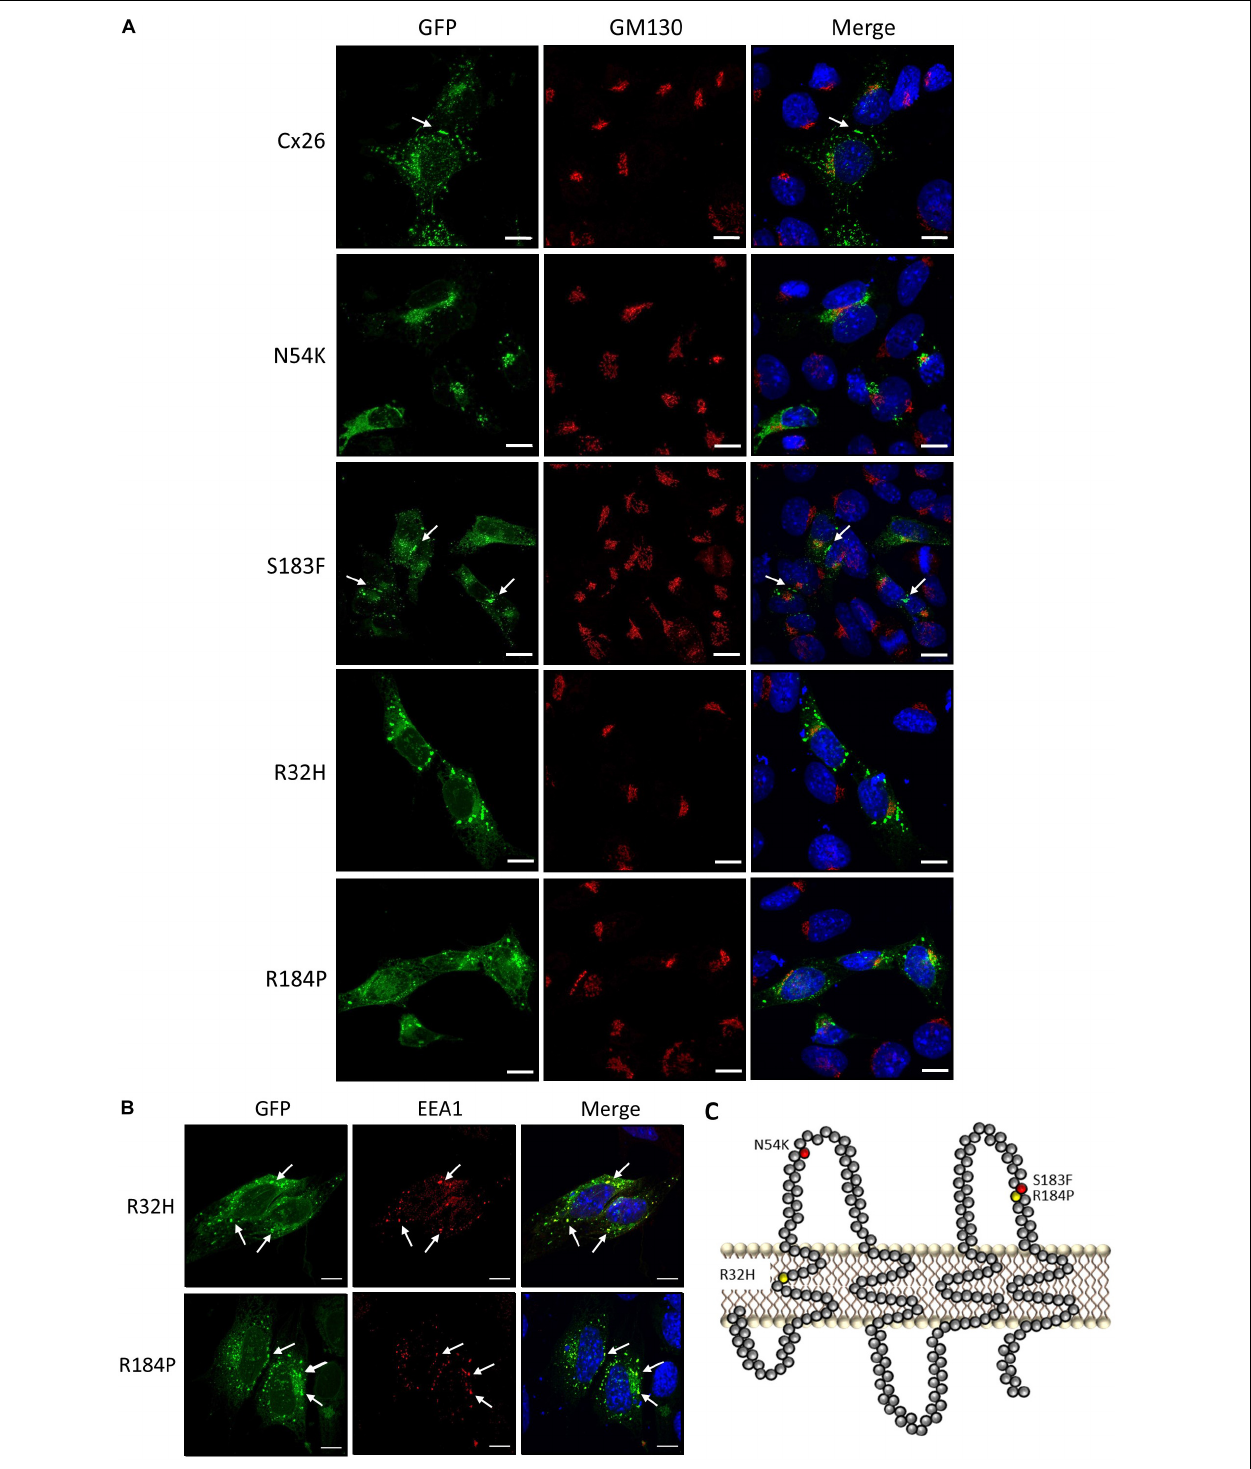
FIGURE 3 | Intracellular localization of syndromic and non-syndromic hearing loss-linked Cx26 mutants (A) Representative micrographs of Cx26-GFP and various GFP-tagged hearing loss-linked Cx26 mutants transiently expressed in Cx43 KO cells. Cells were co-immunolabeled with GM130 (red) to visualize the location of the Golgi apparatus and Hoechst (blue) to visualize the nuclei. The N54K, R32H, and R184P mutants failed to form gap junctions. Arrows denote gap junction plaques. (B) A sub-population of the R32H and R184P mutants co-localized with EEA1, an early endosomal marker, denoted by arrows. (C) Topological model of Cx26 depicting the approximate locations of the syndromic (red) and non-syndromic (yellow) mutations. Bars = 10 µ m.